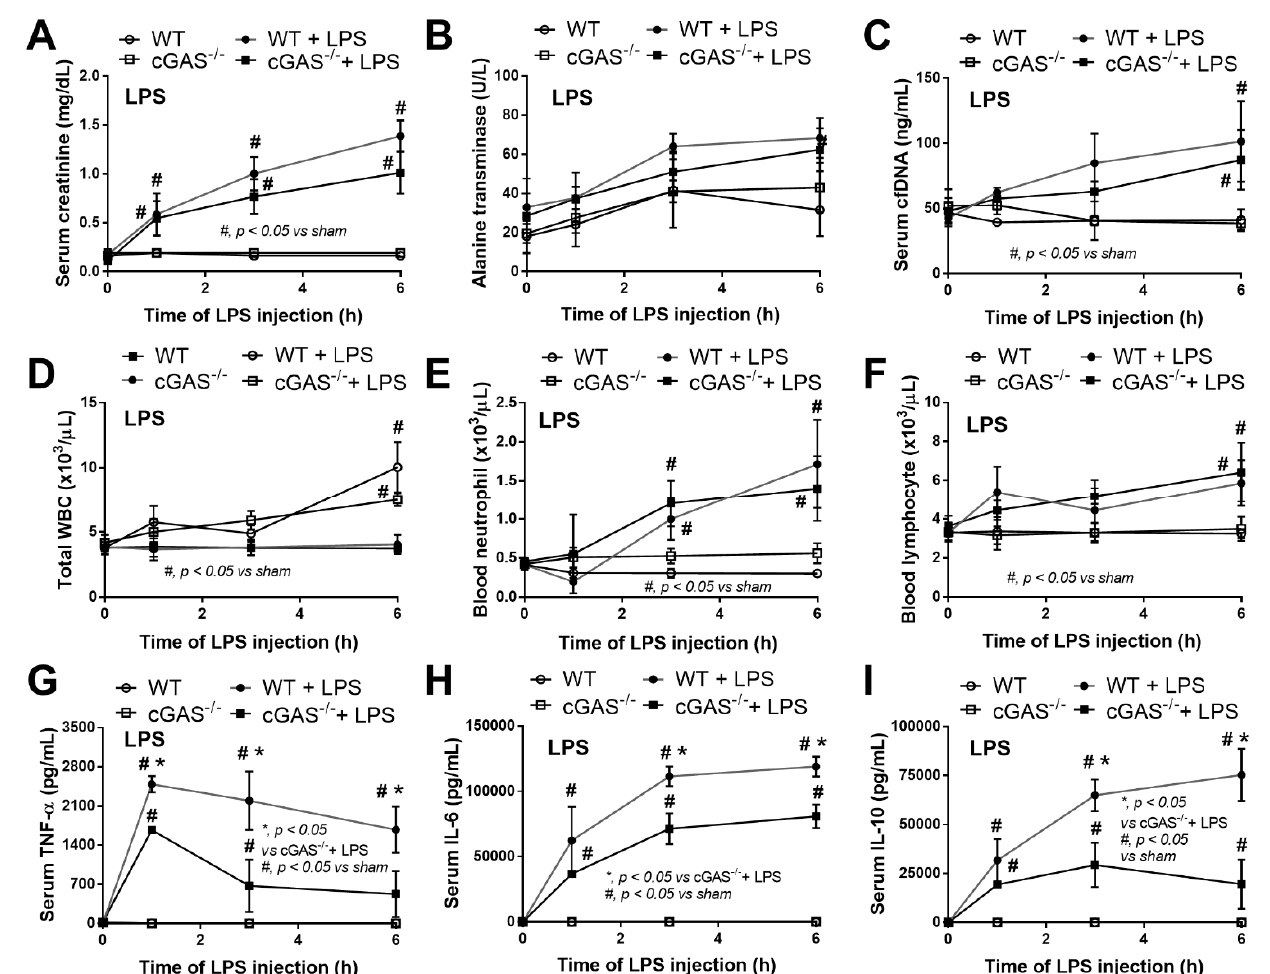
Figure 3. Characteristics of wildtype (WT) and cyclic GMP–AMP synthase deficient (cGAS -/- ) mice after an injection by normal saline or lipopolysaccharide (LPS), as indicated by serum creatinine ( A ), alanine transaminase ( B ), cell free DNA (cfDNA) ( C ), peripheral blood leukocyte (total, neutrophils and lymphocytes) ( D – F ) and serum cytokines (TNF- α , IL-6 and IL-10) ( G – I ) (n = 6–8/time-point).